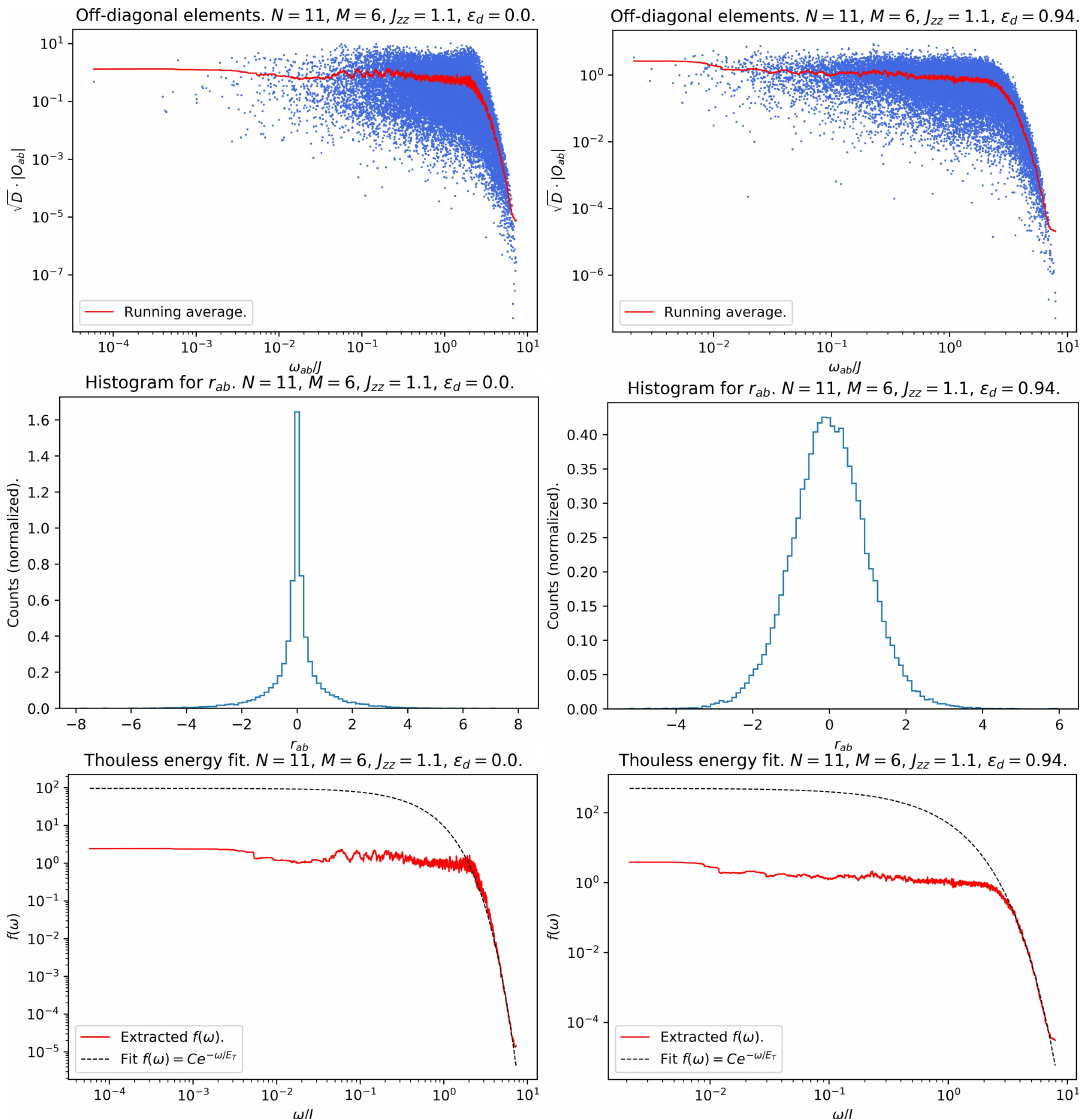
Figure 9. ETH checks for the system and operator studied in figure 4b. On the left we show the integrable regime (cid:15) = 0 while on the right we consider the chaotic regime with (cid:15) = 0 . 94 . Since d d we are studying operators with a zero one-point function, the ETH check can focus on just the off- diagonal elements of the operator in the energy basis. We note, in agreement with previous works (such as [46–48]), that the difference between the integrable and the chaotic phase is subtle: in both cases it is possible to extract a smooth envelope f ( ω ) for the off-diagonal matrix elements of the ab operator as a function of the energy difference ω , whose high-frequency tail can be ab ≡ E a − E b fitted by an exponential form f ( ω ) = Ce − ω/E T yielding in both cases a very similar Thouless energy E T / Λ ∼ 0 . 055 (the r-value of the fit being around 0 . 992 ), where Λ denotes the spectral bandwidth. The difference between the integrable and the chaotic case is that in the former the fluctuations of the off-diagonal elements are not quite Gaussian, and hence they cannot be claimed to fulfill ETH, whereas they become more Gaussian in the latter, where the integrability-breaking defect is